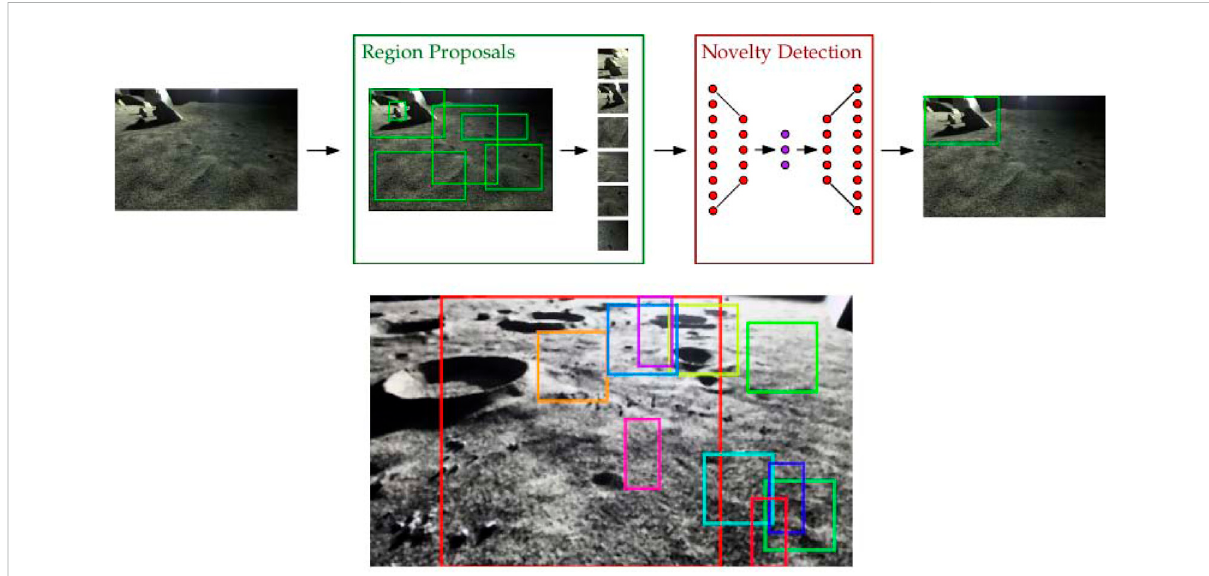
FIGURE 3 ( top ) Schematic of the novel region extraction (NRE) pipeline. NREs cascade a class-agnostic region proposal system with full-image novelty detection and can be trained like traditional reconstruction-based novelty detectors. ( bottom ) Sample of raw, un fi ltered region proposals by the Binarized normed gradients (BING)